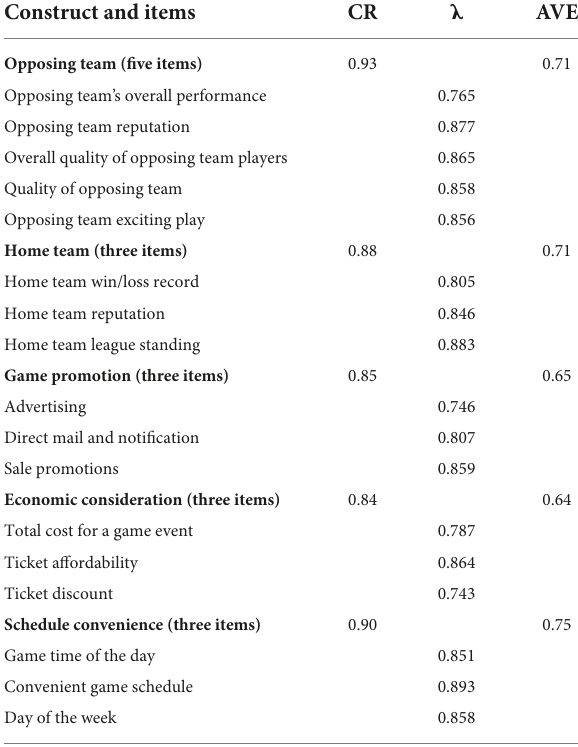
TABLE 2 Summary for measurement model of pull